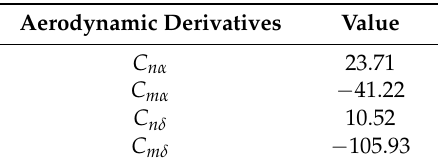
Table 2. Aerodynamic